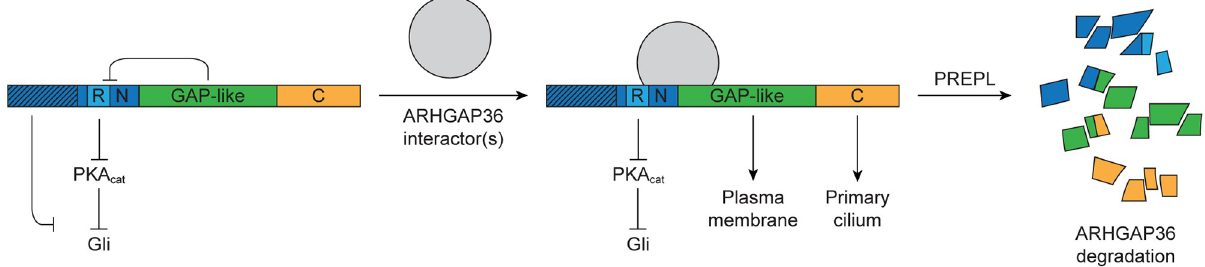
Fig 7. A regulatory model for ARHGAP36 function. Schematic representation of the structural elements that regulate ARHGAP36 localization and activity. N-terminal regulatory regions that vary between ARHGAP36 isoforms are depicted with hash marks.